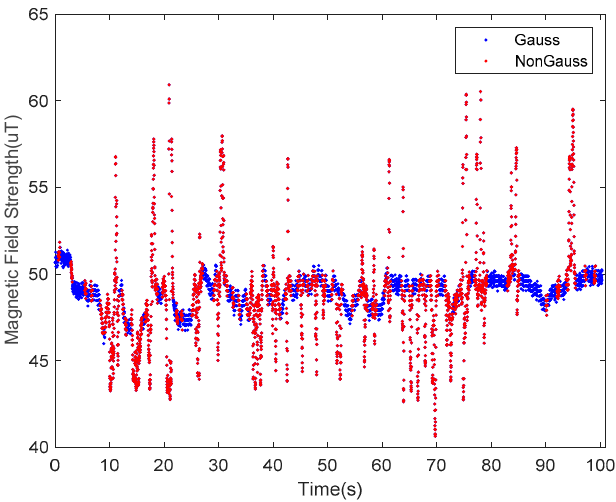
Figure 6. A decision tree extracts interference-free magnetic data from the measurement data of the magnetometer.